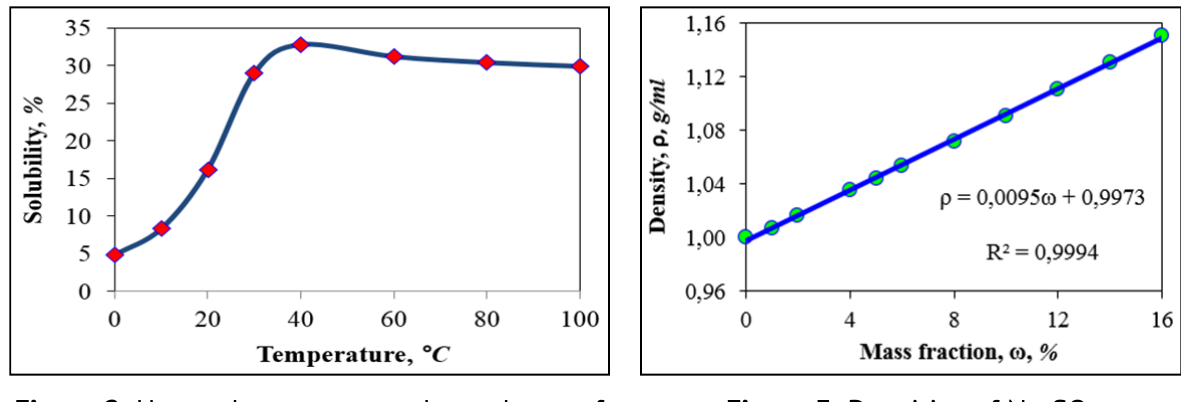
Figure 3. Densities of Na solutions at 20